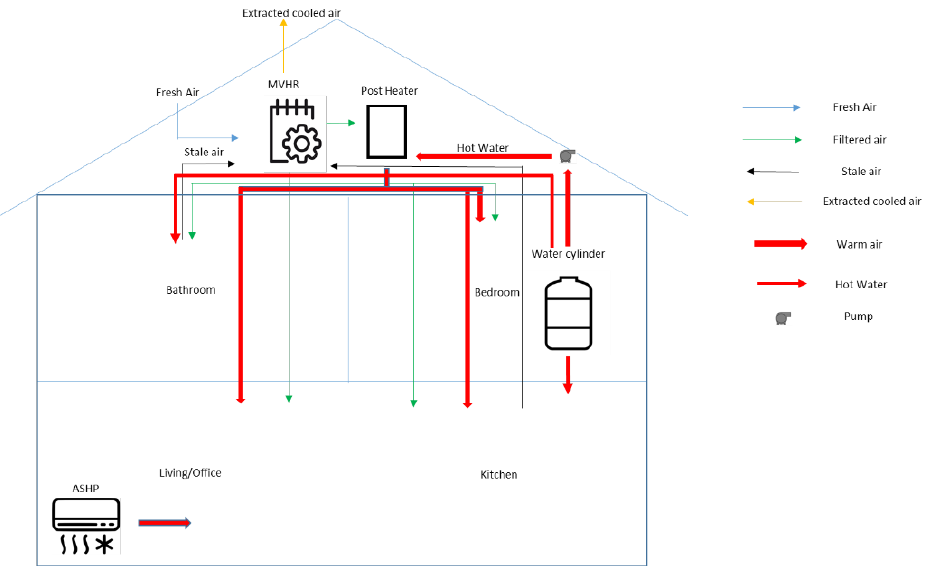
Figure 4. SIPs house schematic.